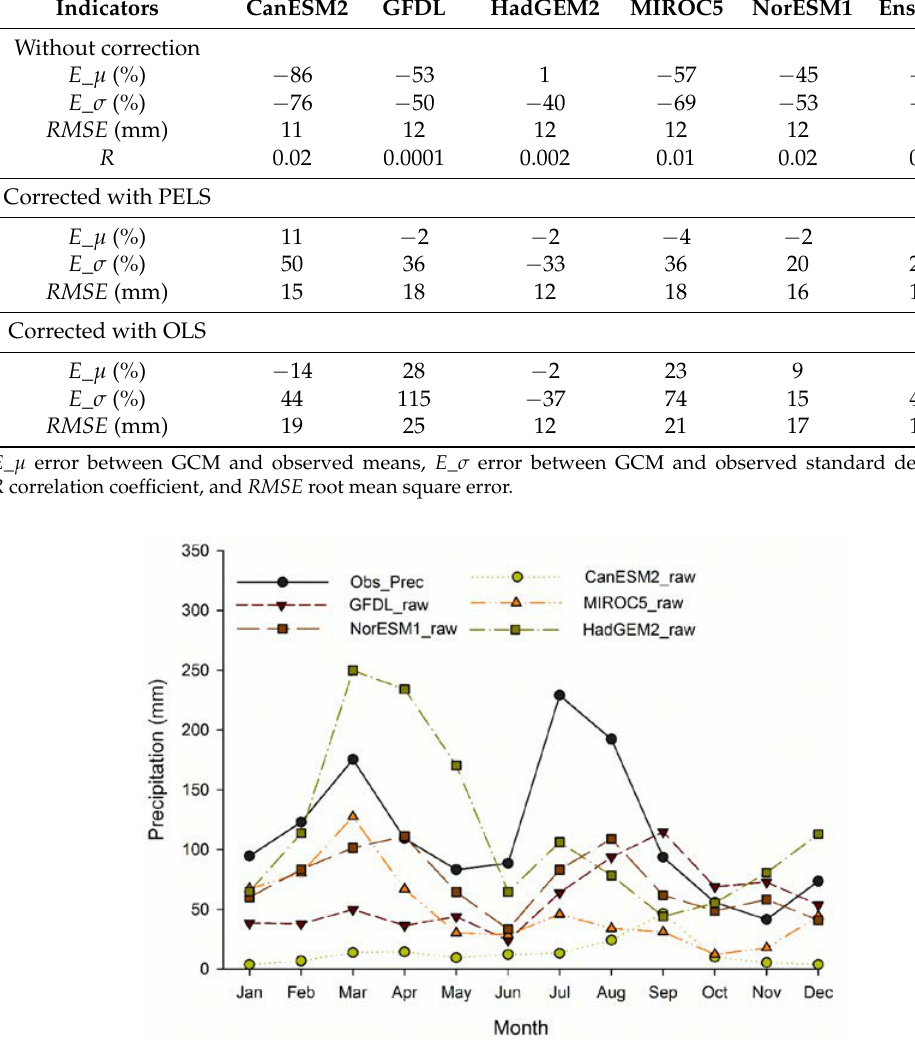
Figure 5. Comparison between observed and GCM raw precipitation for 1986–2000, in the Jhelum River basin.